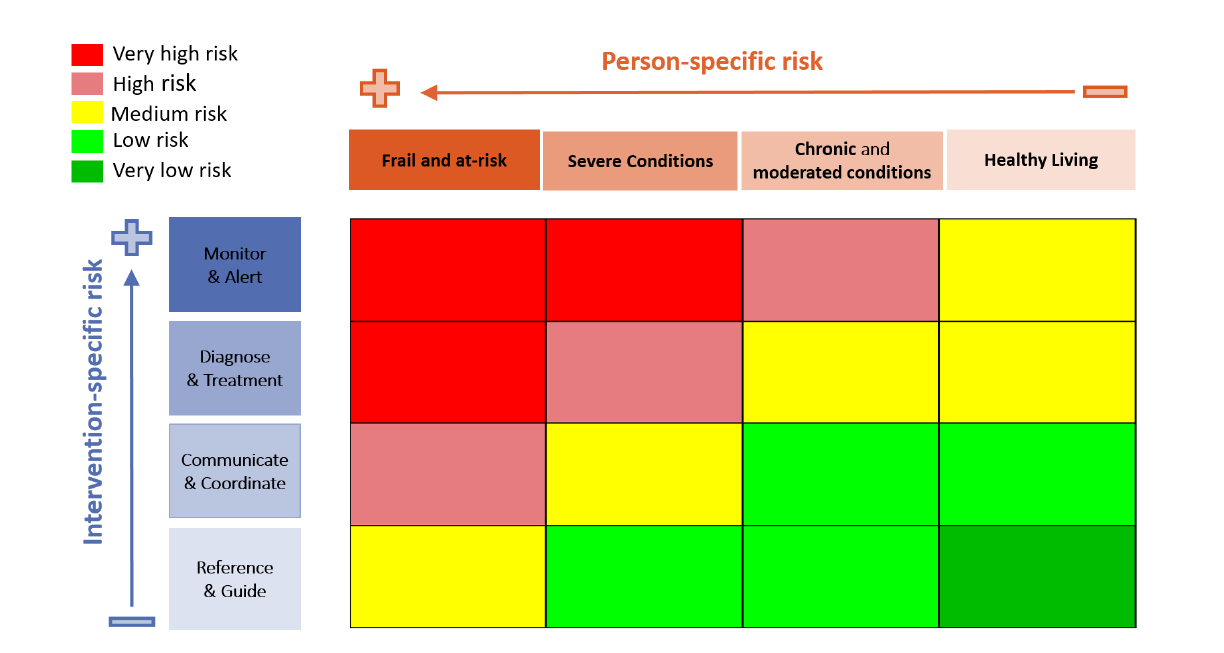
Figure 1. Risk assessment